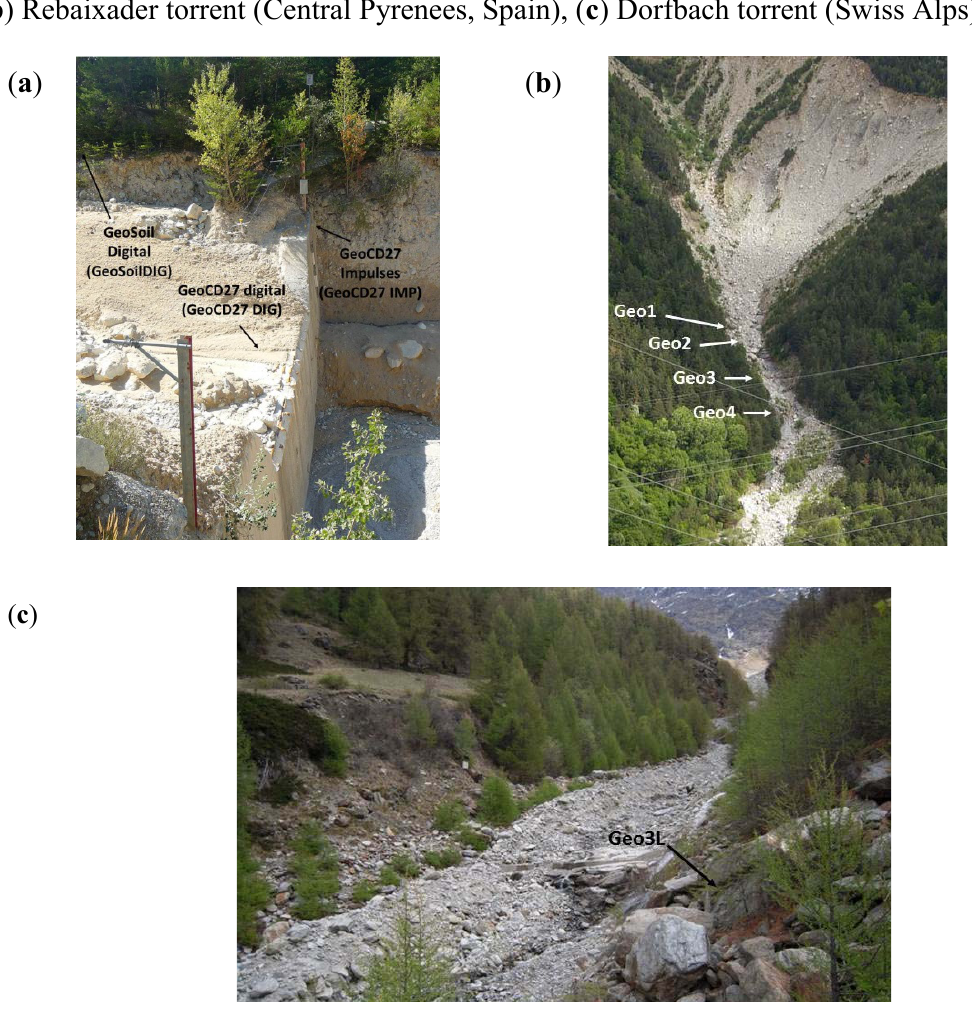
Figure 7. Location of the geophones in the three sites ( a ) Illgraben torrent (Swiss